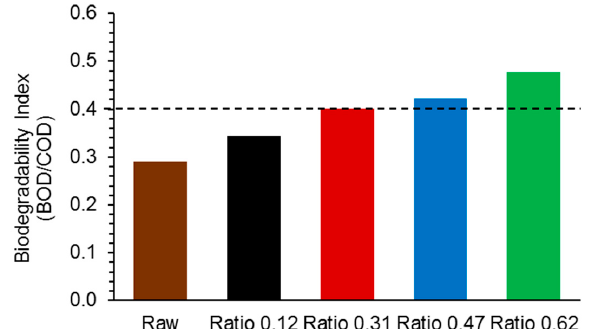
Figure 4. BOD5 to COD ratio of initial and treated sugarcane vinasse at different [H 2 O 2 ] to [COD]